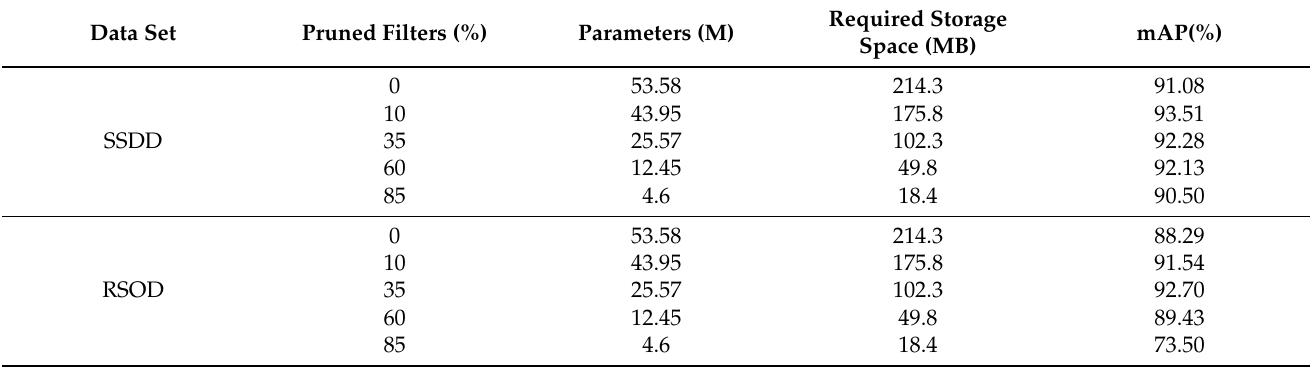
Table 1. Overall pruning results of the absorption pruning method on remote sensing data